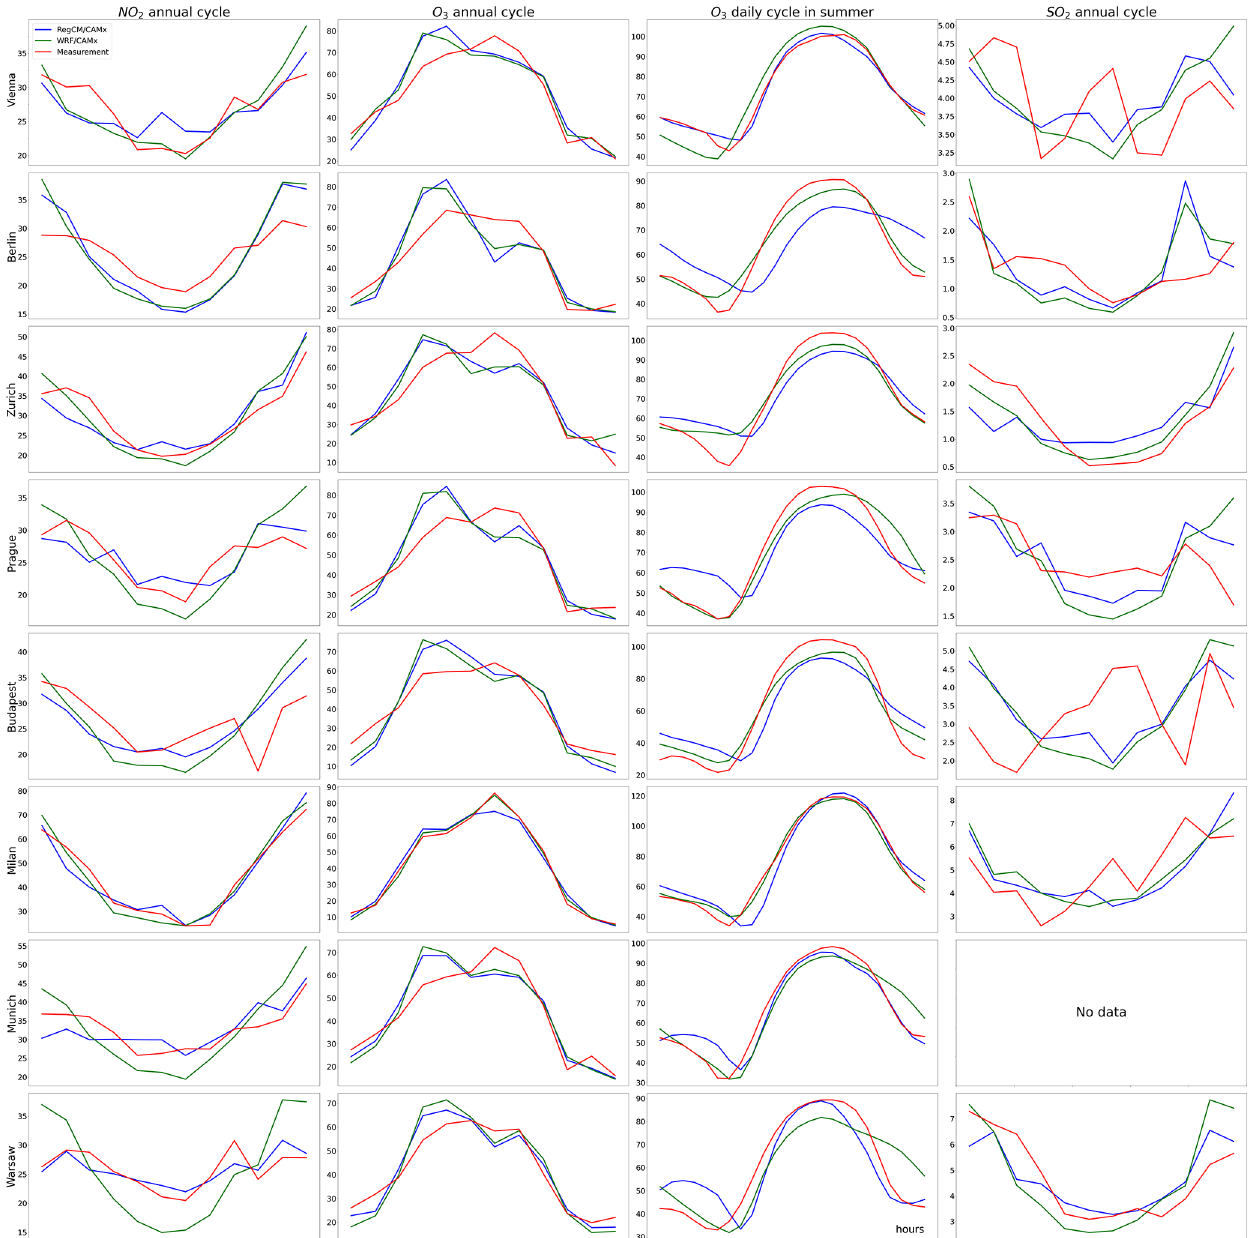
Figure 2. Comparison of modeled (blue – RegCM/CAMx; green – WRF/CAMx) and measured (red; AirBase data) urban and suburban average monthly concentrations of NO 2 (first column) and O 3 (second column), the average JJA diurnal cycle of O 3 (third column), and the average monthly concentrations of SO 2 (fourth column) for 8 different cities selected from the total 19 considered in the study, namely Berlin, Budapest, Milan, Munich, Prague, Zurich, Vienna, and Warsaw (units: µgm − 3 ). Data are averaged across all available urban- and suburban-type background stations within the chosen city. There are no data for SO 2 in Munich as no corresponding measuring station was